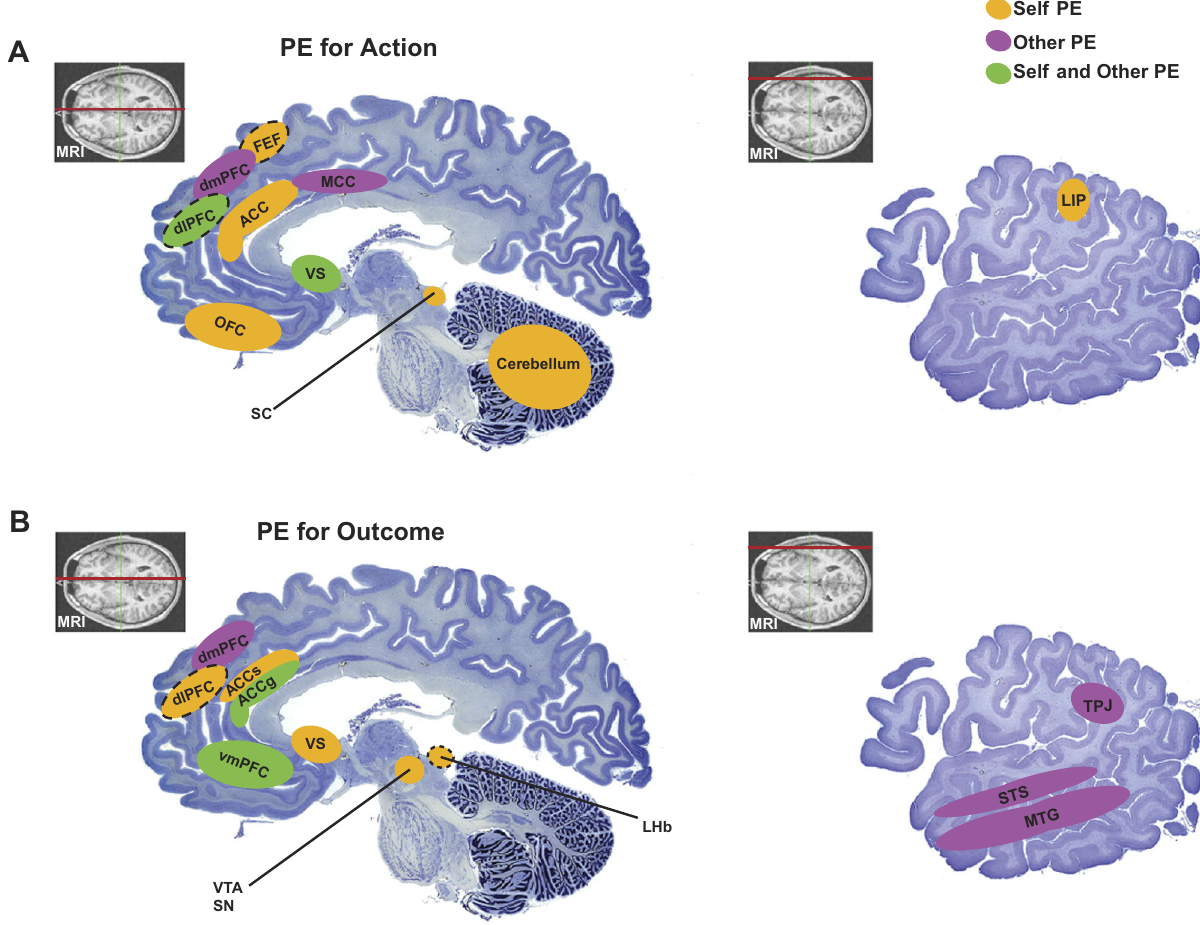
Fig. 2 Key brain regions that have been shown correlates of self-referenced prediction errors (in yellow ) or other-referenced prediction errors (in purple ), or both kinds of prediction errors (in green ) in the domain of actions ( a ) and reward/value outcomes ( b ). For motor learning-related errors, we only provide representative areas as they are beyond the scope of this review. It is worthwhile to note that the distributions of these areas for their involvements in self-referenced or other-referenced prediction error signaling are naturally constrained by the amount of research examining different types of prediction errors. The insets with coronal magnetic resonance images indicate the sections ( red line ) that correspond to the Nissl-stained sagittal slices. The dotted outline around an area indicates that this area is projected medially from the lateral surface for the purpose of including the area on a more medial aspect of the brain. Adapted with permission from http://www.brains.rad.msu. edu, http://brainmuseum.org, supported by the US National Science Foundation and the National Institutes of health. ACC anterior cingulate cortex, ACCg anterior cingulate gyrus, ACCs anterior cingulate sulcus, dlPFC dorsolateral prefrontal cortex, dmPFC dorsomedial prefrontal cortex, LHb lateral habenula, LIP lateral intraparietal area, MTG medial temporal gyrus, OFC orbitofrontal cortex, SC superior colliculus, SN substantia nigra, STS superior temporal sulcus, TPJ temporoparietal junction, vmPFC ventromedial prefrontal cortex, VS ventral striatum, VTA ventral tegmental